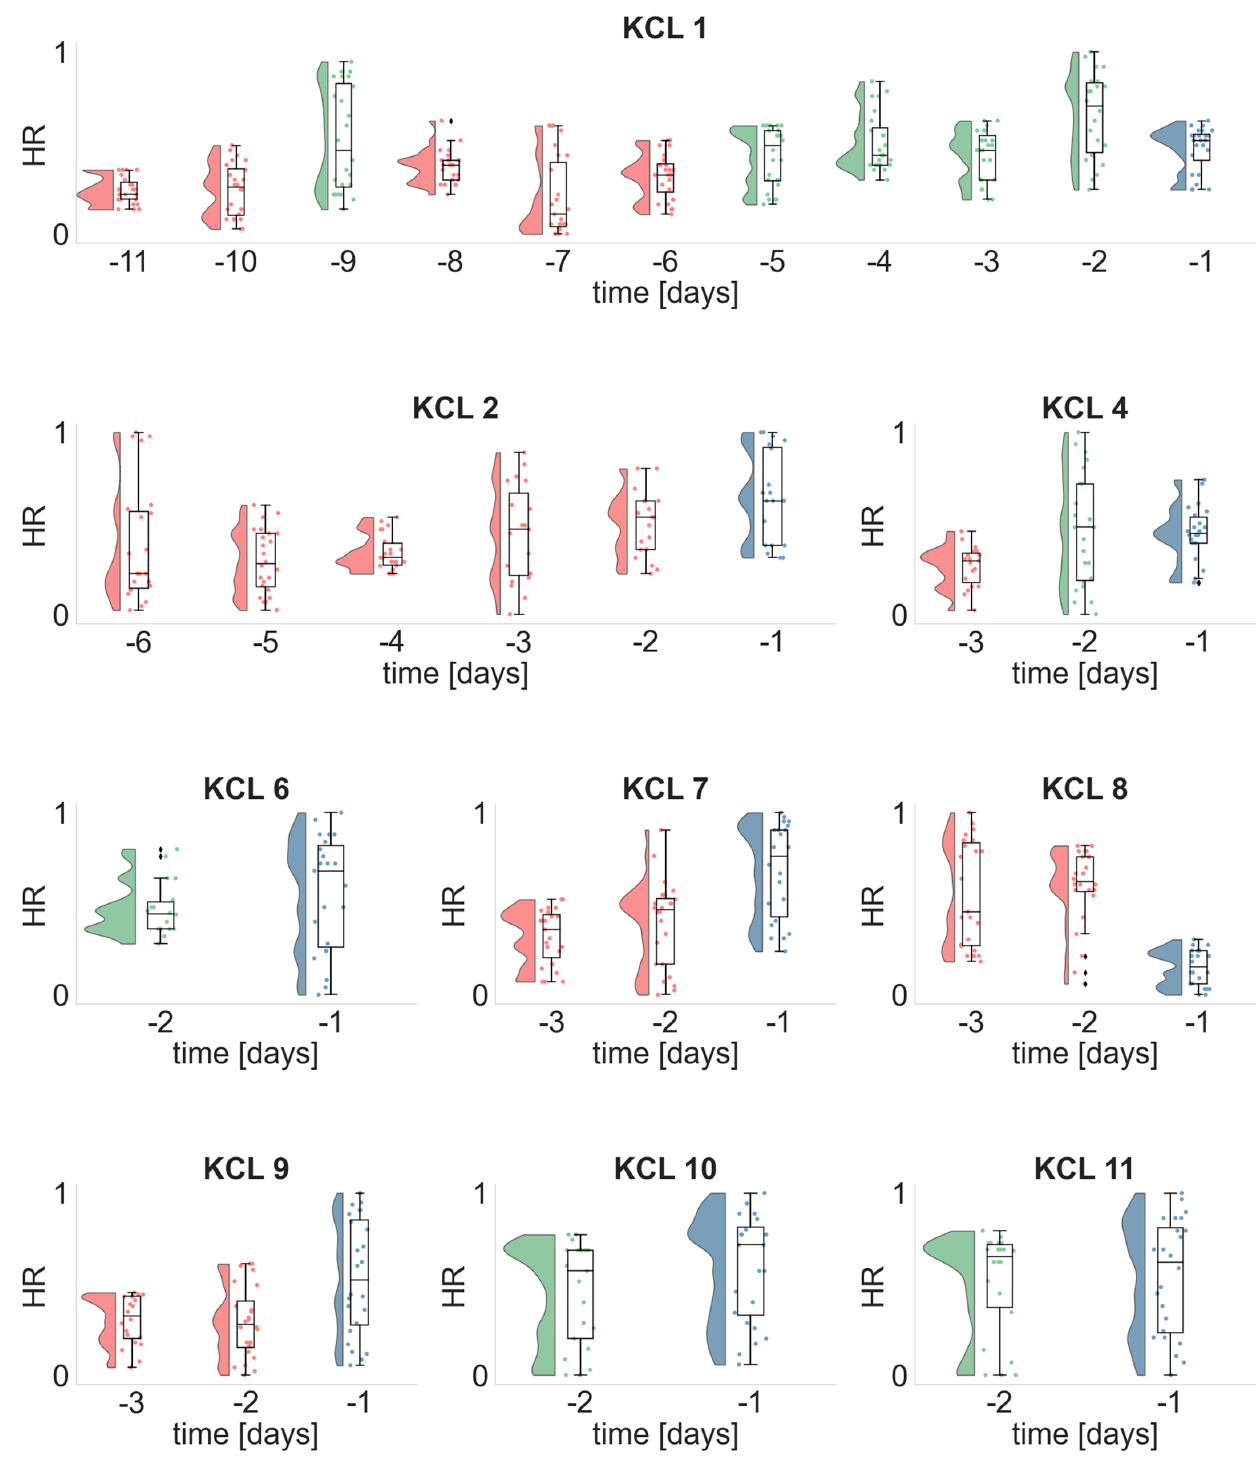
Figure 5. Daily distributions of the heart rate HR for each seizure free day prior to seizure occurrence. Dots illustrate the HR values obtained from each analyzed ECG segment, whilst histograms and boxplots depict their distribution. Horizontal lines in the boxplots indicate the median. The day before the seizure occurrence, i.e., d − 1 is denoted with blue. Days whose distributions are statistically significantly different (one-sided Wilcoxon rank sum test) from the distribution of day d − 1 are illustrated in red, otherwise are depicted in